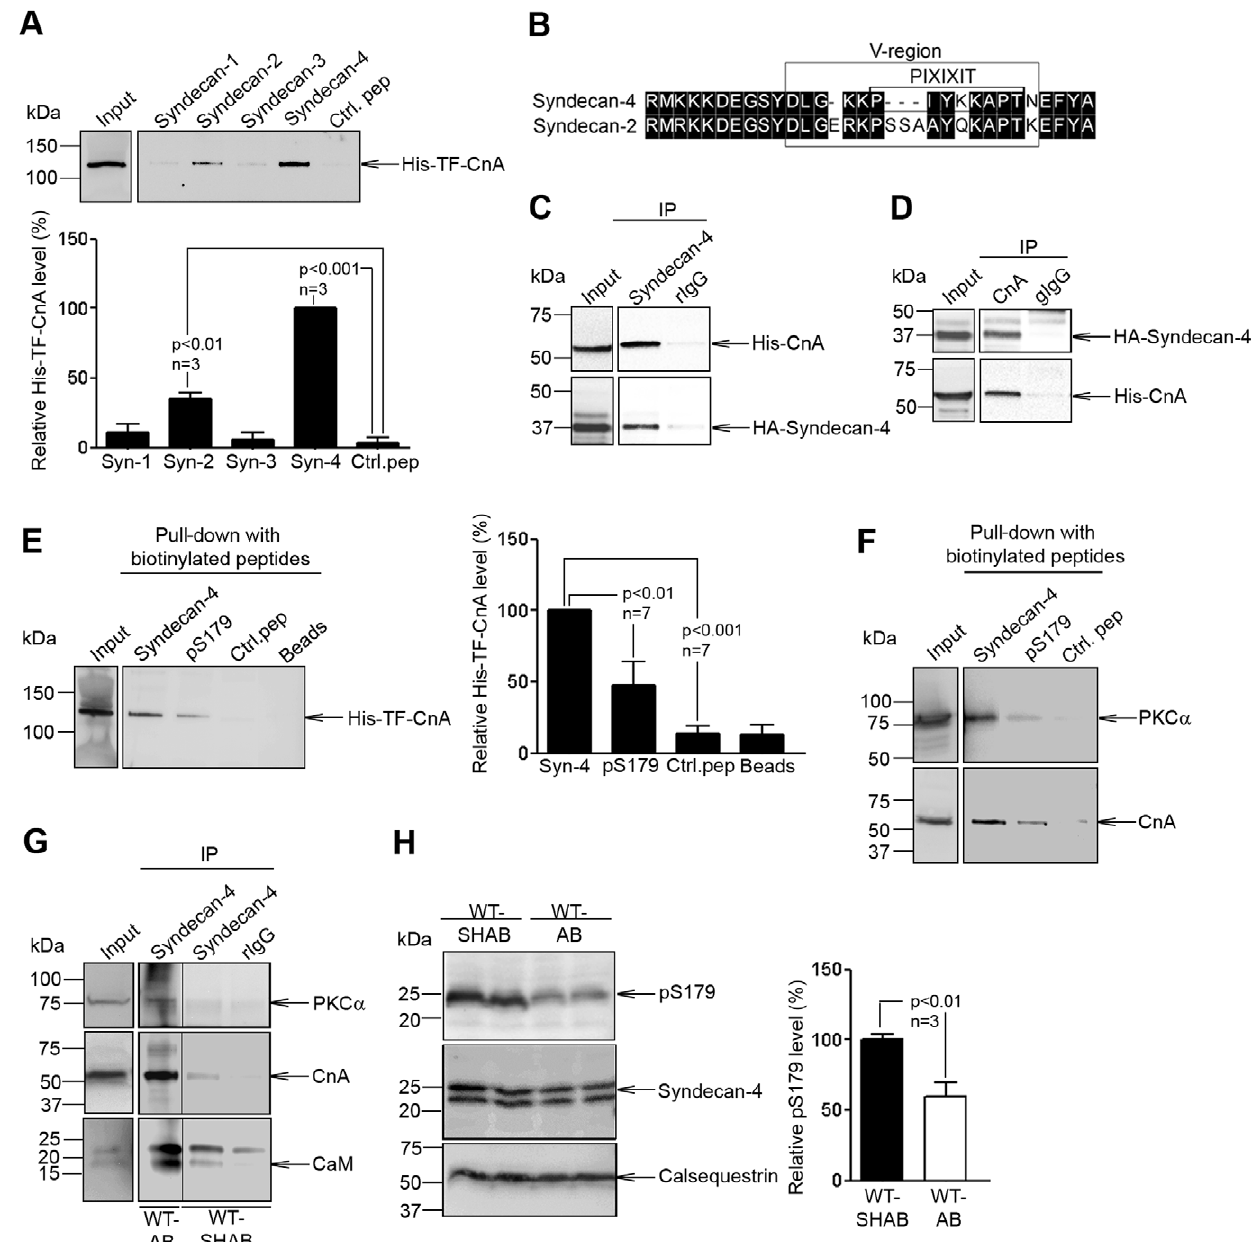
Figure 4. Association of syndecan-4 with calcineurin A (CnA). (A) Pull-down experiments with biotinylated peptides covering cytoplasmic domains of syndecan-1–4 were performed using recombinant His-trigger factor (TF)-CnA, and precipitates immunoblotted for presence of His-TF-CnA (n=3). (B) Alignment of syndecan-4 and syndecan-2. Black boxes indicate similar amino acids within consensus region. Lysates from HEK-293 cells co- transfected with syndecan-4 and CnA subjected to immunoprecipitation with (C) anti-syndecan-4 (n=3) or (D) anti-CnA (n=3) were immunoblotted with anti-CnA or anti-syndecan-4, respectively. Pull-down experiments with biotinylated peptides covering non-phosphorylated or phosphorylated cytoplasmic part of syndecan-4 were performed using recombinant His-TF-CnA (E) or left ventricular (LV) tissue before immunoblotted for presence of endogenous CnA (n=3) and PKC- a (n=2) (F). (G) LV tissue extracts from WT-SHAB and WT-AB were immunoprecipitated with anti-syndecan-4 or control IgG and lysates and immunoprecipitates immunoblotted for presence of PKC- a , CnA and calmodulin (CaM, n=2). (H) Relative pS179- syndecan-4/total syndecan-4 levels in aorta-banded (AB) versus sham-operated (SHAB) WT LV tissue (n=3). Calsequestrin was used for loading control. Values are mean 6 s.e.m.